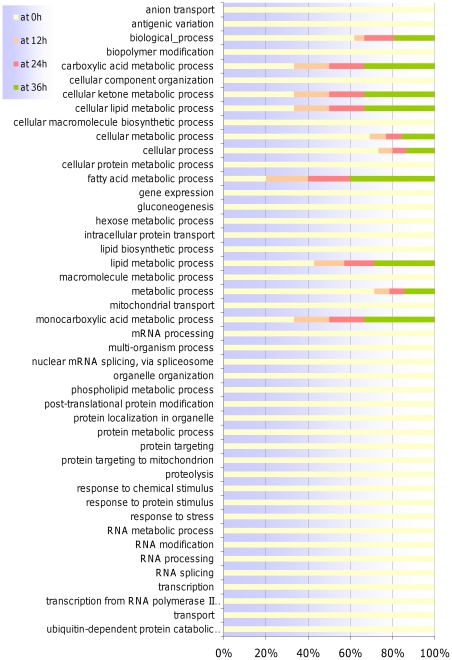
Gene Ontology (GO) analysis at main time points of the P. falciparum asexual life cycle.The time points color legend is indicated at the top left corner of the barplot. GO enrichment is indicated as stacked percentages.